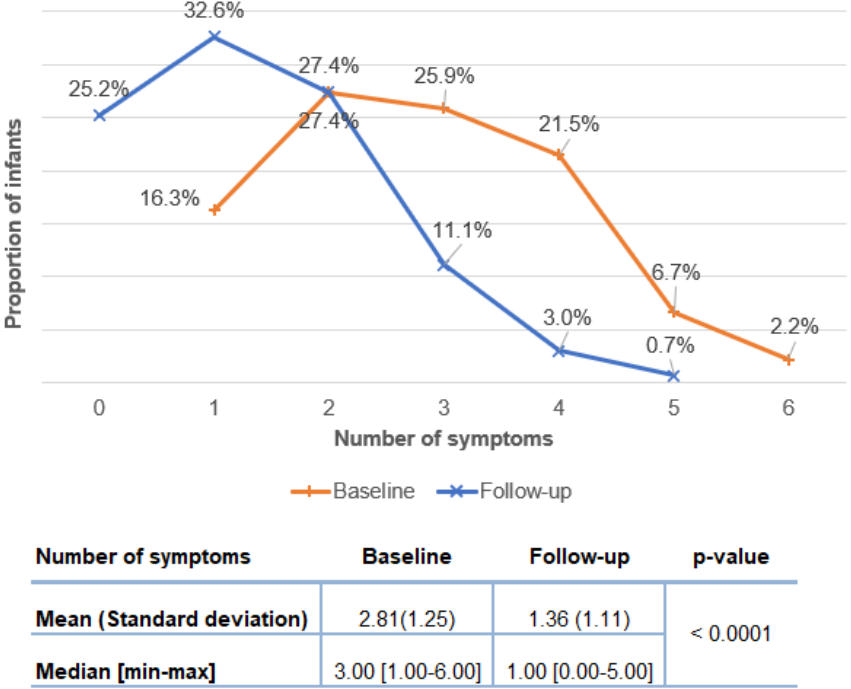
Figure 4. Breakdown of infants according to the number of symptoms at baseline and follow-up. The initiation of the study formula defined the “Baseline” visit and the “Follow-up” visit that was three to five weeks later. Mean (Standard deviation) and median [min-max] values at baseline and follow-up were compared with a Wilcoxon test on matched samples. n = 135.